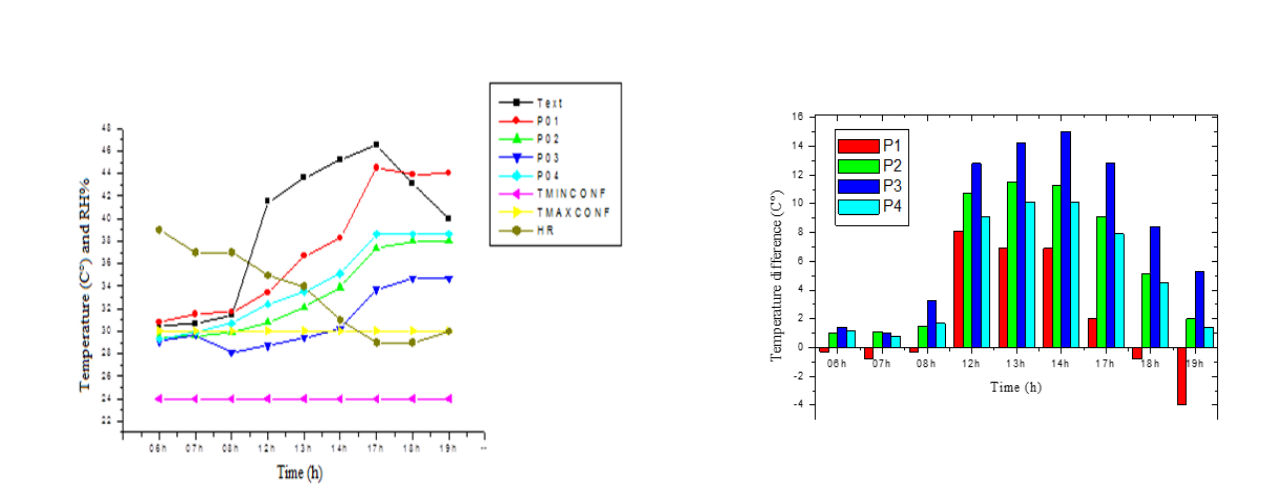
Figure 16. Internal, external temperature and humidity variation during the day.